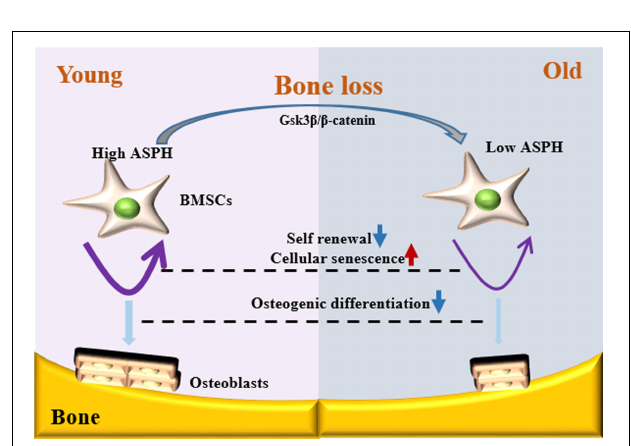
FIGURE 7 | Schematic representation of ASPH regulating cellular senescence and osteogenic differentiation of BMSCs during aging. Low expression of ASPH restrains the accumulation and activation of Gsk3 β and β -Catenin to maintain the capacity of self-renewal and osteogenic differentiation. In the old individuals, the decrease of ASPH is companied with the cellular senescence and impaired osteogenic differentiation of